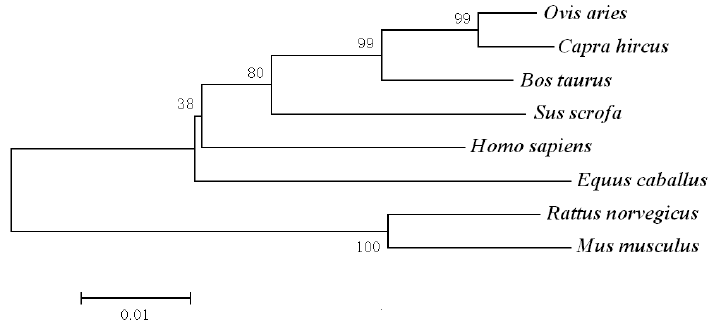
Figure 1. Phylogenetic tree for IGFBP-5 genes in seven species. The cloned goat IGFBP-5 gene nucleotide sequence was aligned with other homologous animal IGFBP-5 genes. The phylogenetic tree was constructed by the neighbor-joining method using MEGA 4.1 software. The species and GenBank accession numbers are Ovis aries (EU727460), Capra hircus (JF720883), Bos taurus (NM_001105327), Sus scrofa (SSU41340), Homo sapiens (NM_000599), Equus caballus (XM_001490309), Rattus norvegicus (NM_012817) and Mus musculus (BC057447). The genetic relationship between goat and sheep is very